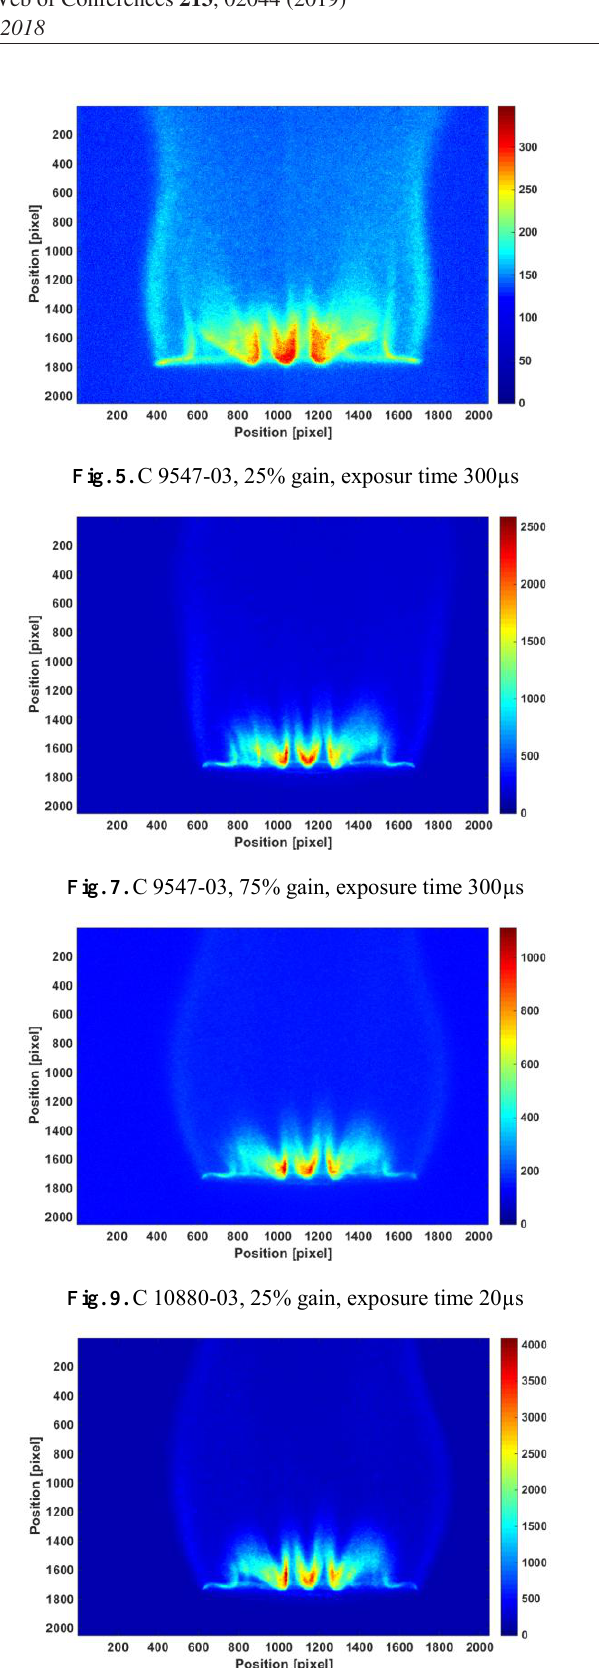
Fig. 11. C 10880-03, 60% gain, exposure time 300µs